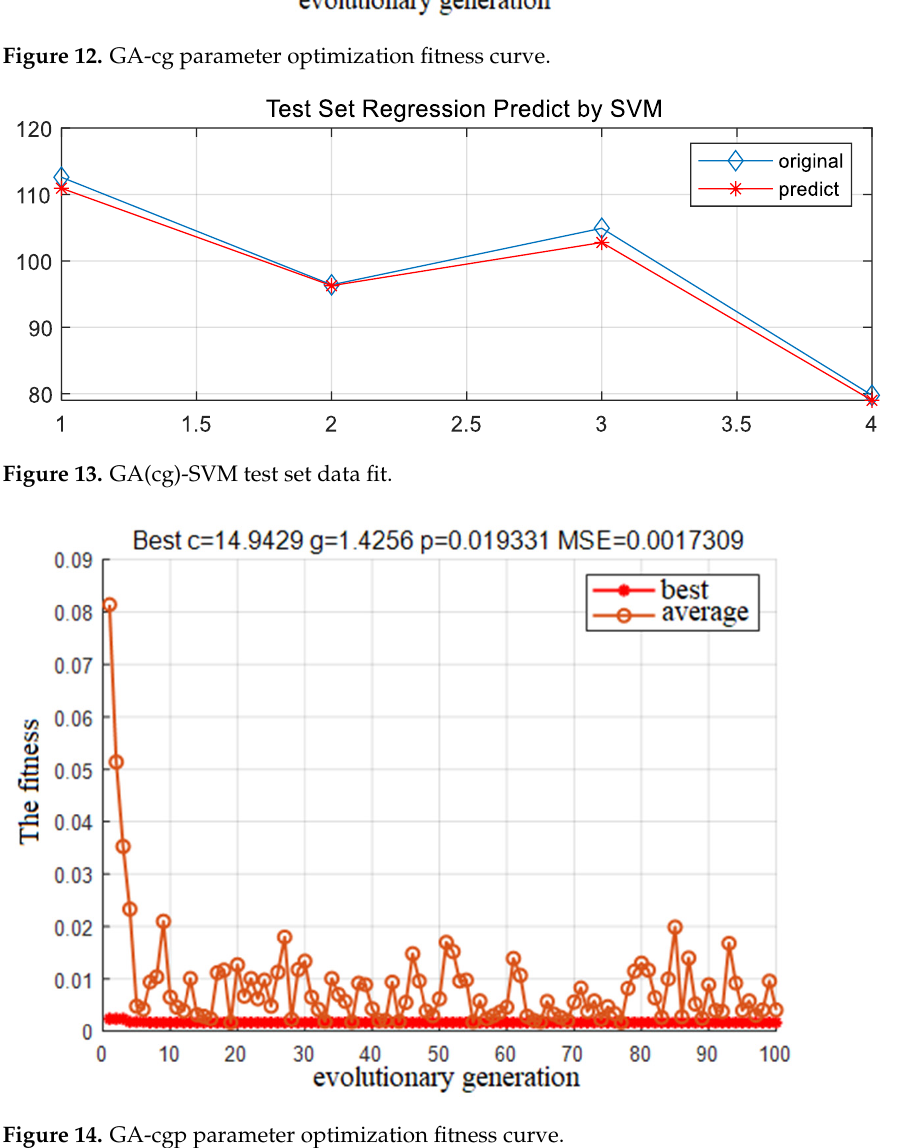
Figure 15. GA(cgp)-SVM test set data fit. For the fitting conditions of the four optimization algorithms combined with SVM for the training set and the test set, the mean absolute error and the mean square error are introduced to test the difference between the predicted value and the true value. 𝑒 = 𝑥 (cid:3021) − 𝑥 (cid:3017) (17) Based on the MATLAB platform running toolbox and related compiler handles, the regression model test set results of four different optimization algorithms are obtained. The accuracy evaluation of the four algorithms is shown in Table 6: